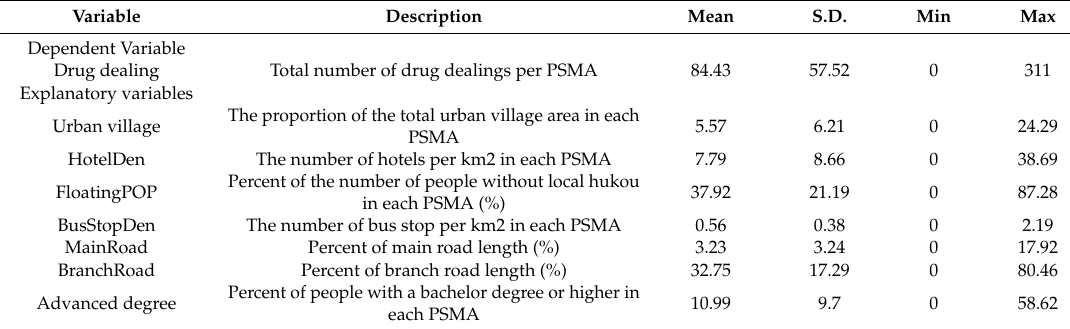
Table 1. Descriptive statistics of variables.